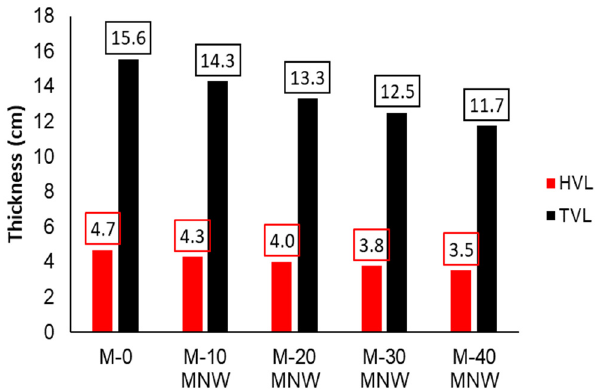
Figure 8. Thickness of HWC mixes at a photon energy of 0.66 MeV for 137 Cs.